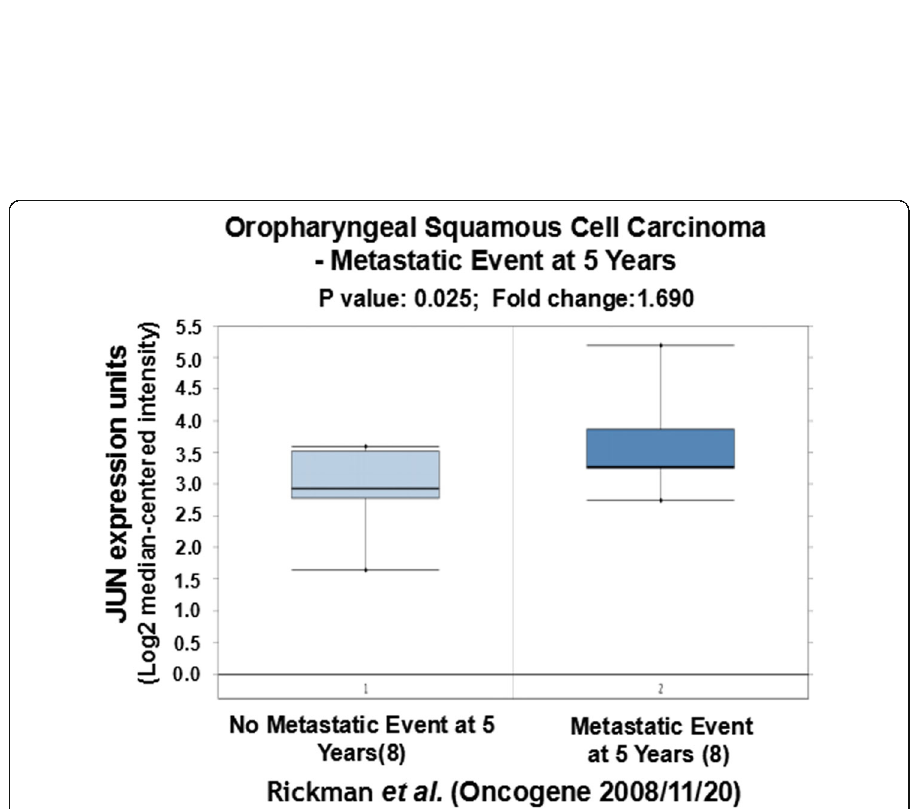
Fig. 6 Comparison of JUN expression in oropharyngeal squamous cell carcinoma without metastatic events at 5 years and with metastatic events at 5